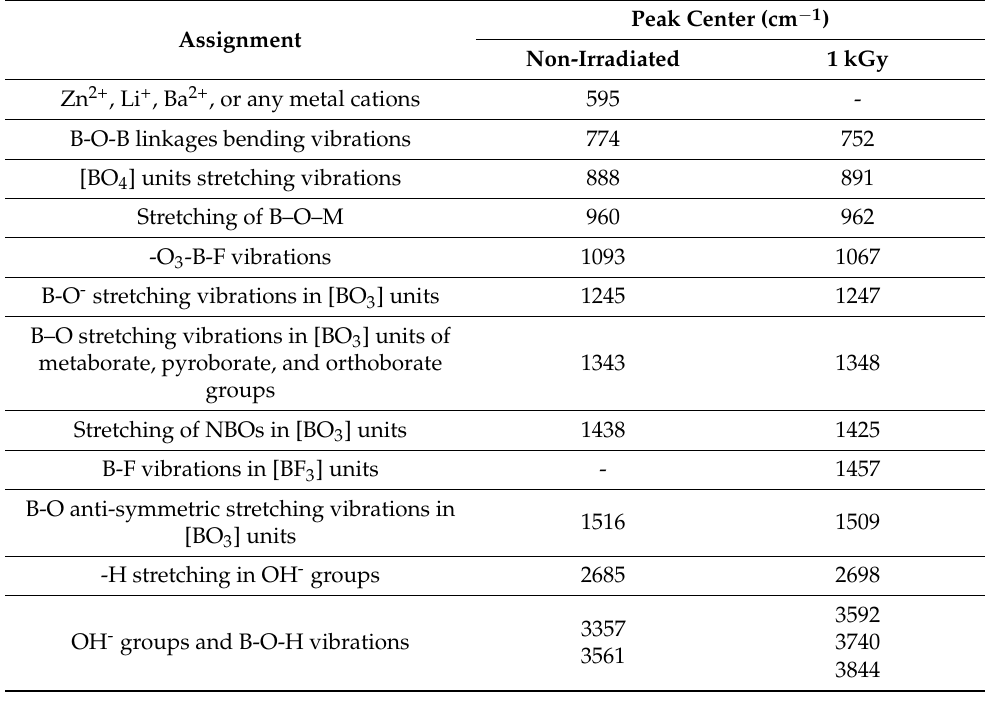
Table 3. FTIR peak assignments of the ZLBBY0.1 glass.